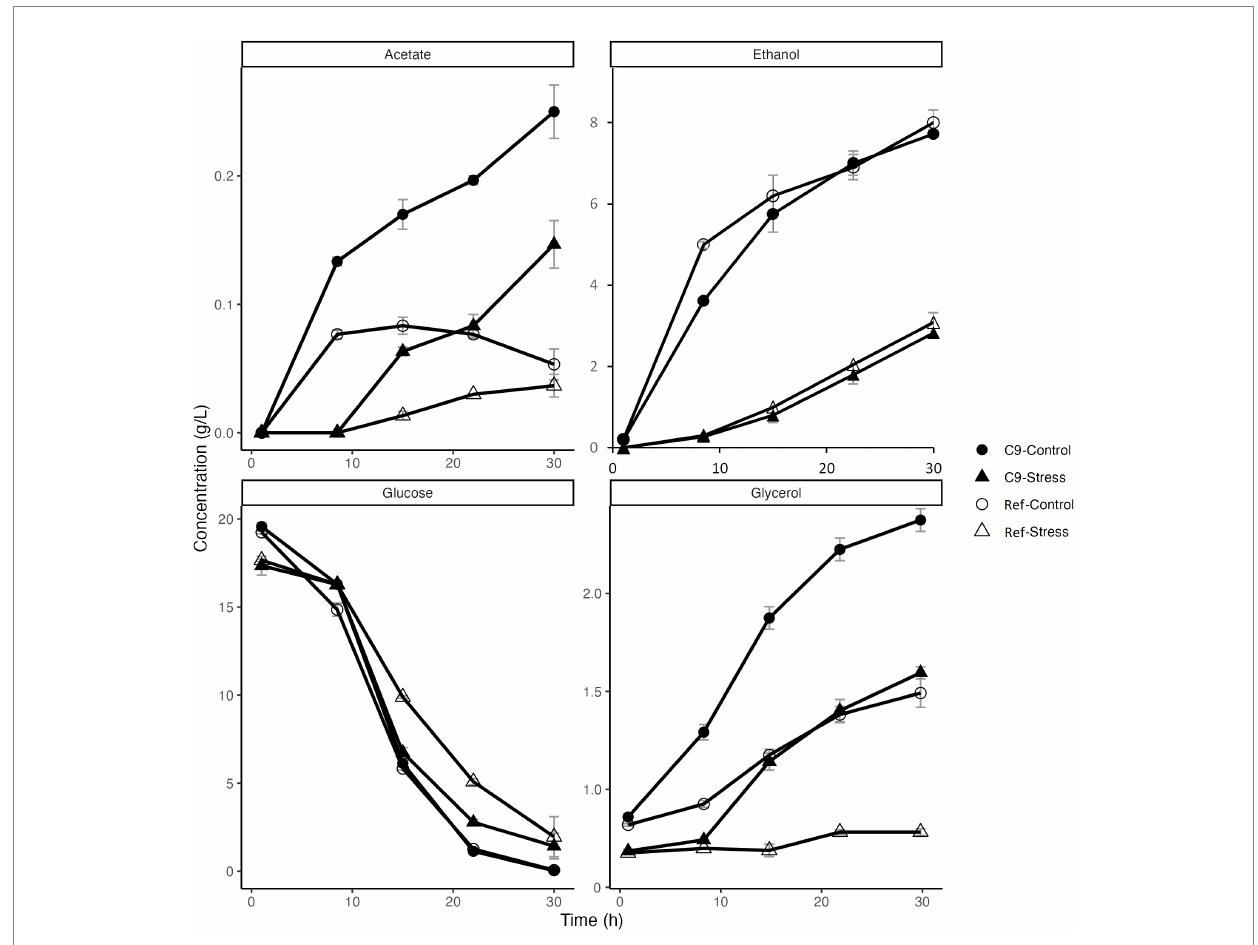
FIGURE 4 Metabolite profiles of the reference strain (Ref) and the evolved strain C9 in the absence and presence of 3 g/L 2-phenylethanol stress.